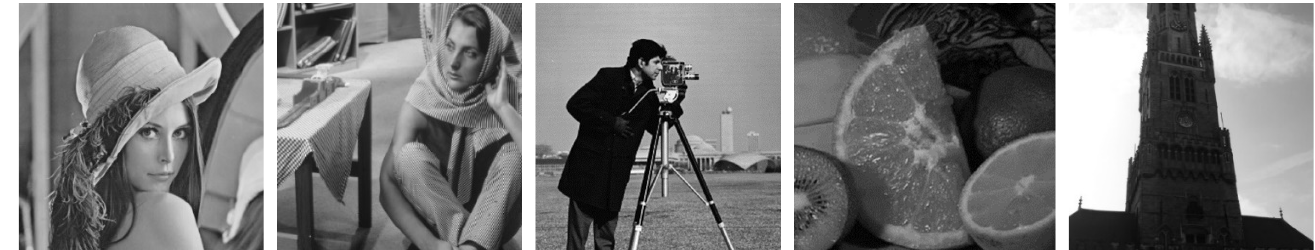
Figure 15. Test images used in the experimental results of Tables 7 and 8. Table 7. Average metrics using the images of Figure 15 𝐹, 𝐶 = 8 .